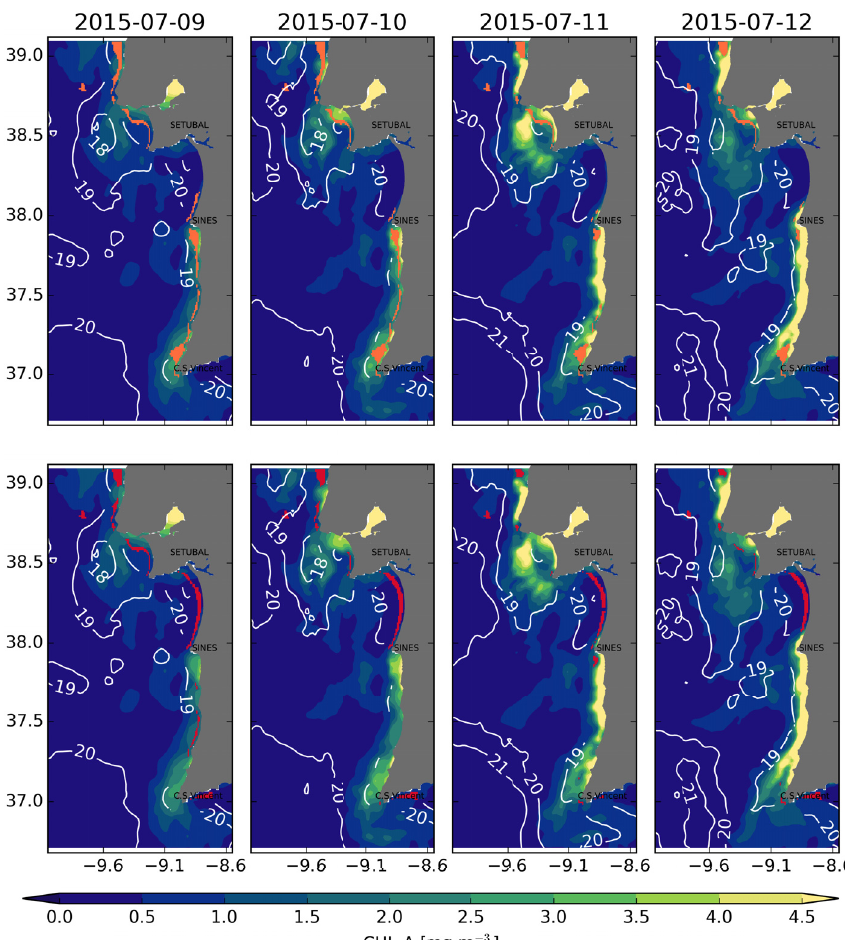
Fig. 5. Daily maps of potential fi shing areas (PFA) showing in orange and red the regions where the daily oceanographic conditions during 9 – 12 July 2015 corresponded to higher catches of sardine (top) and chub mackerel (bottom) for the WAOI, based on the bivariate SST – Chl-a catch distributions in Figure 4a and b. Chl-a concentrations as colour shadings and SST as isothermals (in °